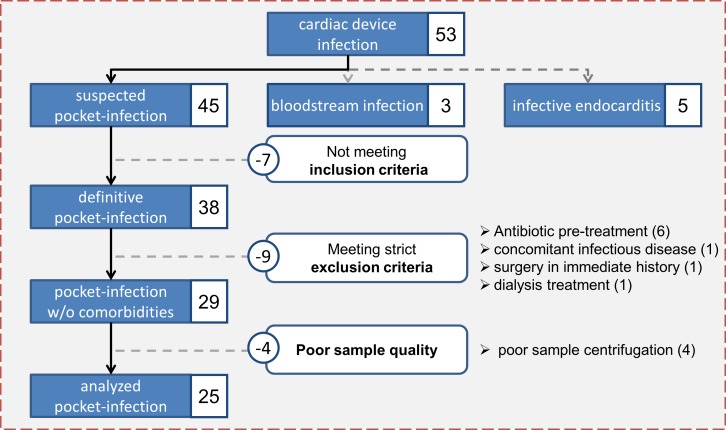
Study flow chart.